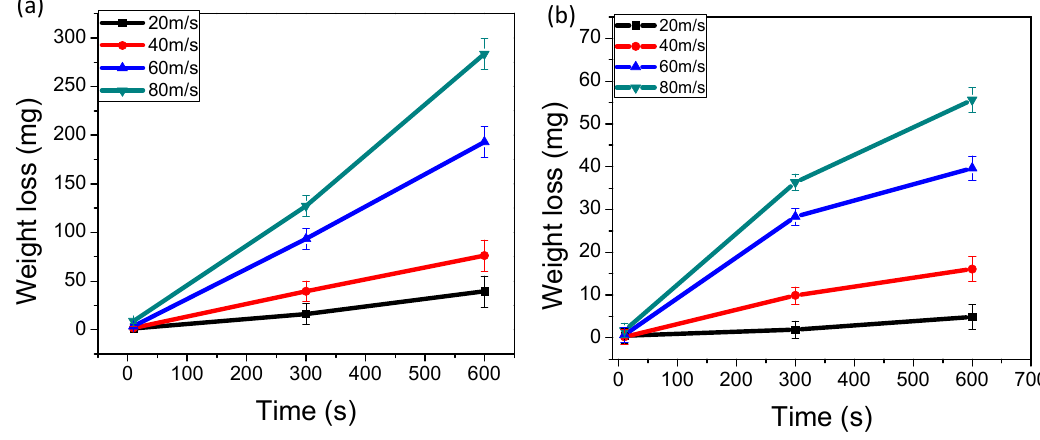
Figure 4. The weight loss of API X100 steel at different speeds for ( a ) 30° and ( b ) 90° impact angles.